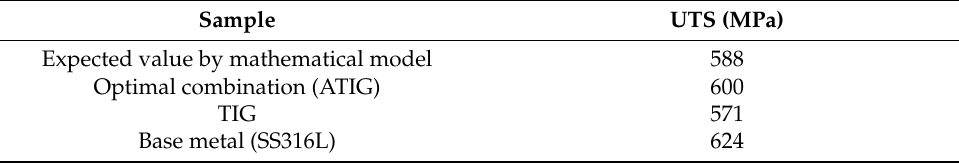
Table 9. UTS comparison between mathematical model, ATIG, TIG, and base